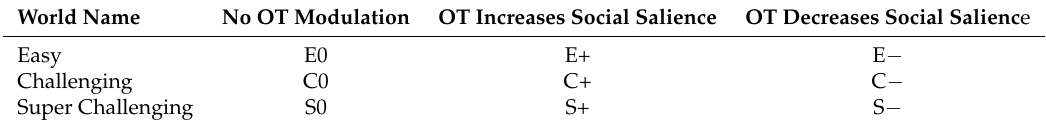
Table 4. Summary of the three groups to which agents were allocated regarding the modulation of social salience by OT, and of the notation used. E refers to Easy world conditions, C refers to Challenging world conditions, and S refers to Super Challenging world conditions; 0, + and − are used to denote conditions with no OT, Increased Social Salience through OT modulation, and Decreased Social Salience through OT modulation, respectively.